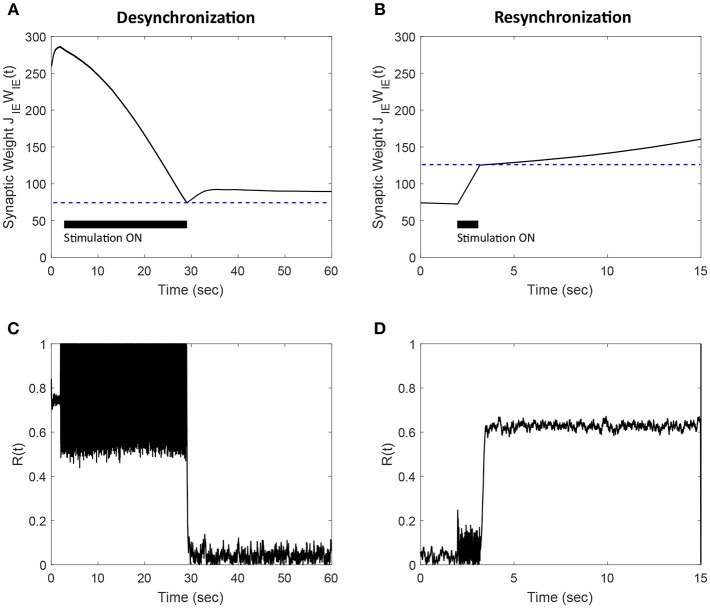
Efficacy of the FTSTS strategy in desynchronizing (A,C) and resynchronizing (B,D) a 2,000 neuron E-I network with symmetric plasticity. (A) Shows the decrease in average synaptic weight of the network with the modified FTSTS protocol for symmetric plasticity. (C) shows the change in the synchrony of the network before, during, and after stimulation. (B) Shows the increase in average synaptic weight of the network with the modified FTSTS protocol for symmetric plasticity. (D) Shows the change in the synchrony of the network before, during, and after stimulation. The FTSTS parameters used to decrease the average E-to-I synaptic weight are Ustim = 200 mV, Tstim = 1 ms, Tneutral = 22 ms, and Toffset = 11 ms. The FTSTS parameters used to increase the average E-to-I synaptic weight are Ustim = 100 mV, Tstim = 1 ms, Tneutral = 10 ms, and Toffset = 5 ms.